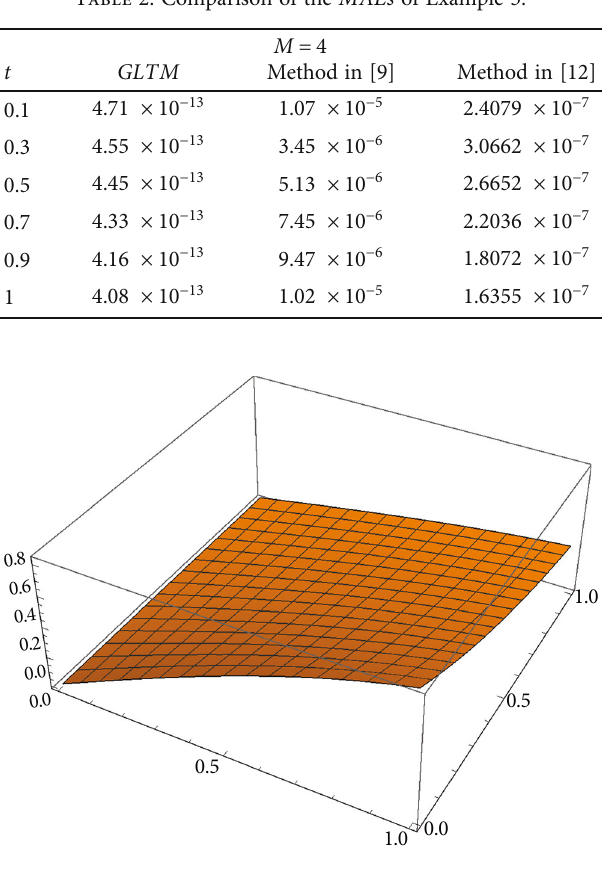
Figure 1: Exact solution for Example 5.